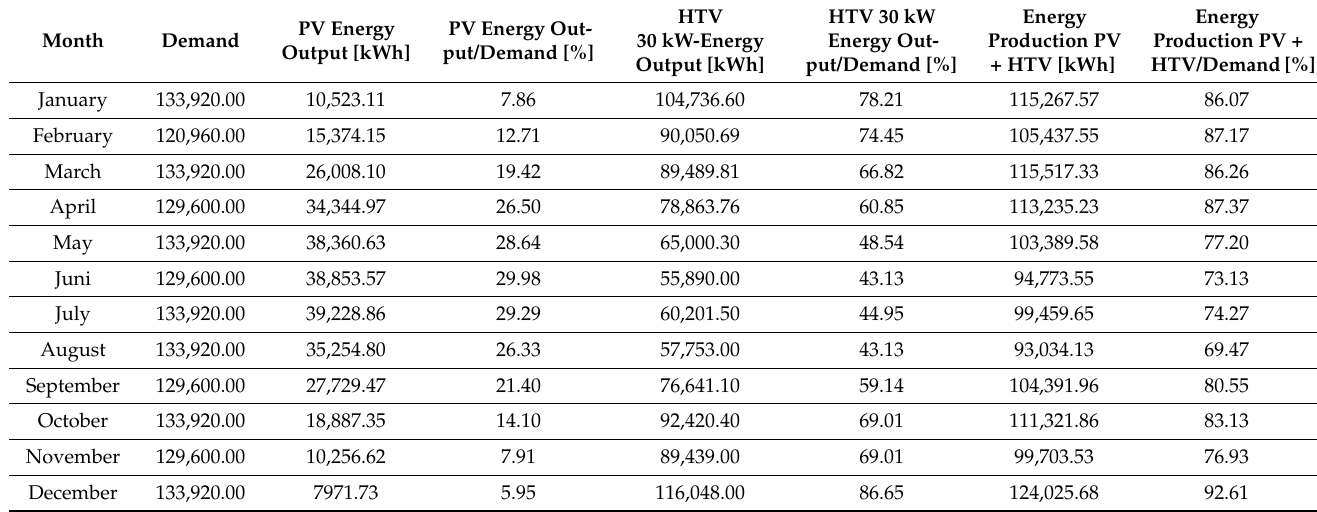
Table 12. Average amounts of energy generated by PV installations and windmill systems with 1 × PV 600 kWp + 10 × HTV 30